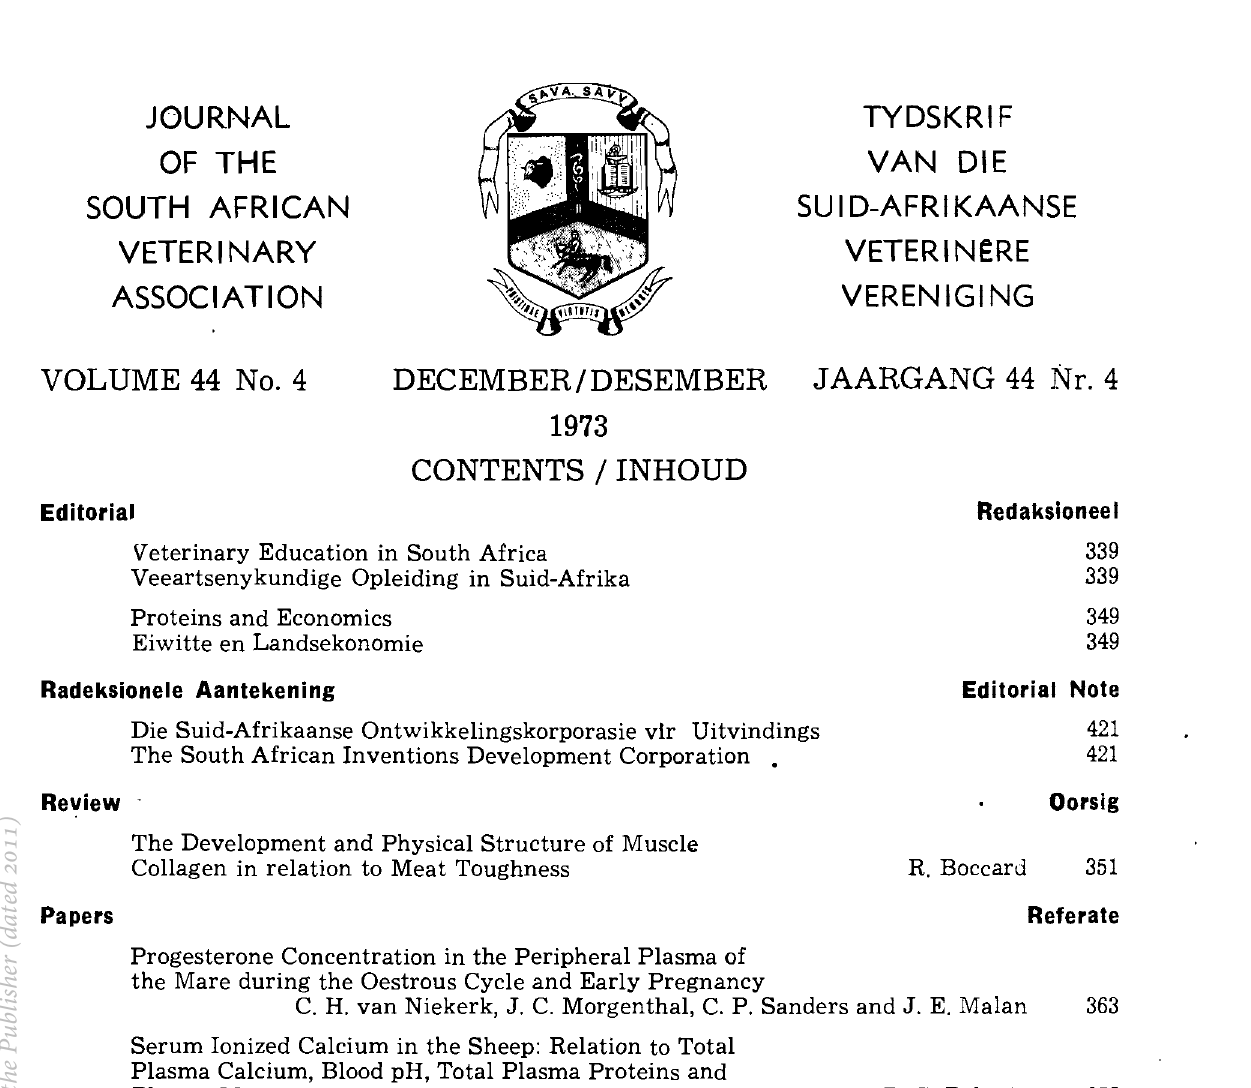
Progesterone Concentration in the Peripheral Plasma of the Mare during the Oestrous Cycle and Early Pregnancy C. H. van Niekerk, J. C. Morgenthal, C. P. Sanders and J. E. Malan Serum Ionized Calcium in the Sheep: Relation to Total Plasma Calcium, Blood pH, Total Plasma Proteins and Plasma